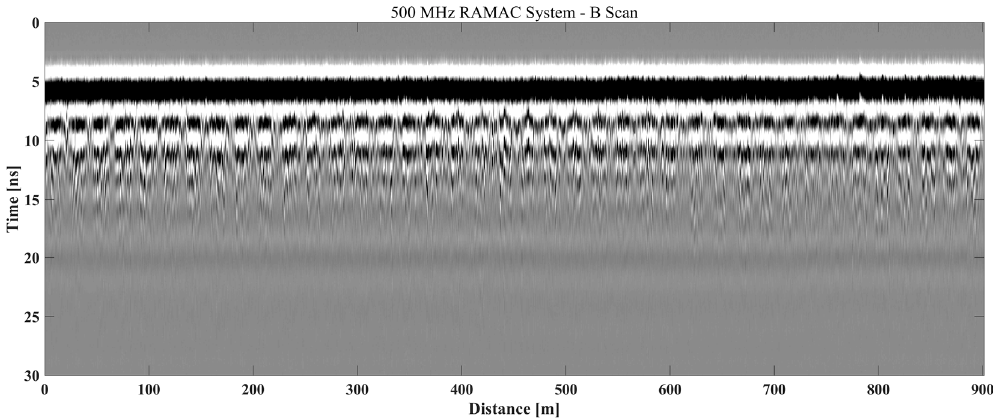
Figure 3. Raw radargram of the tree root investigation using a 500 MHz RAMAC shielded antenna system.